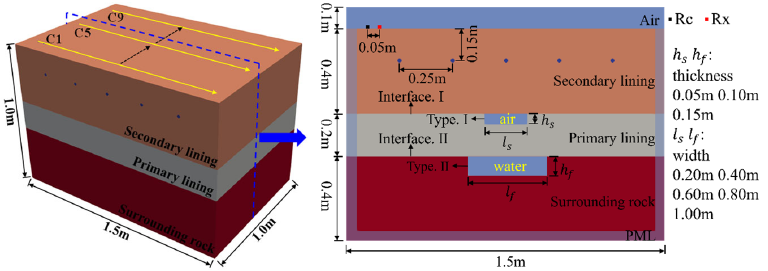
Figure 3. Proposed forward model. The figure illustrates the size and position of the components in the model, including the number of measuring lines, and the range of size variation of voids.